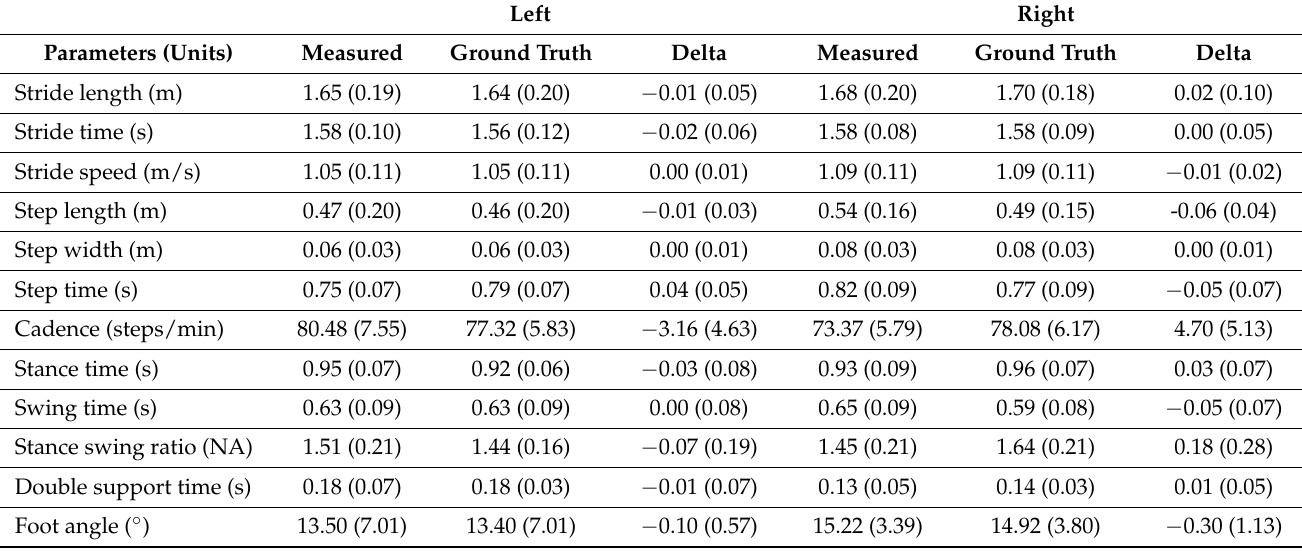
Table A10. Stride parameters for participant two: cane test (mean and standard deviation in brackets). Left